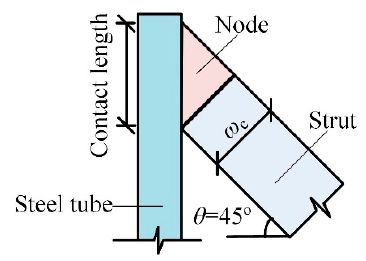
Figure 4. Details of the grouted sleeve connection.